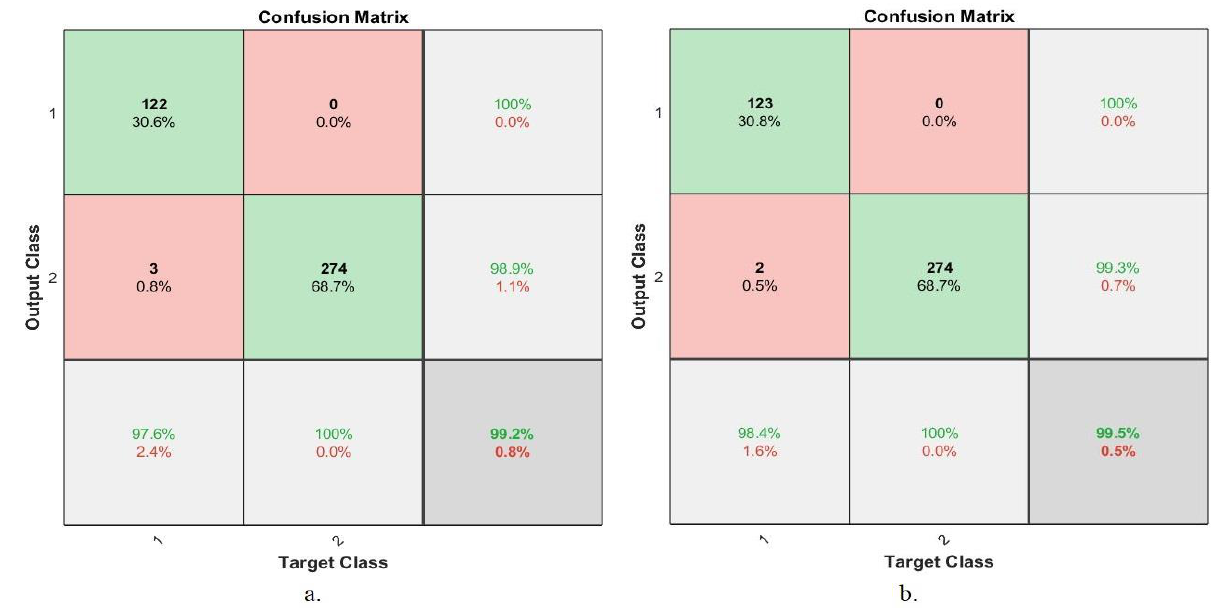
Figure 11. Confusion matrix for ANN for classifying a 40× dataset based on fusion features by ( a ) AlexNet with FCH, LBP, and GLCM and by ( b ) GoogLeNet with FCH, LBP, and GLCM.